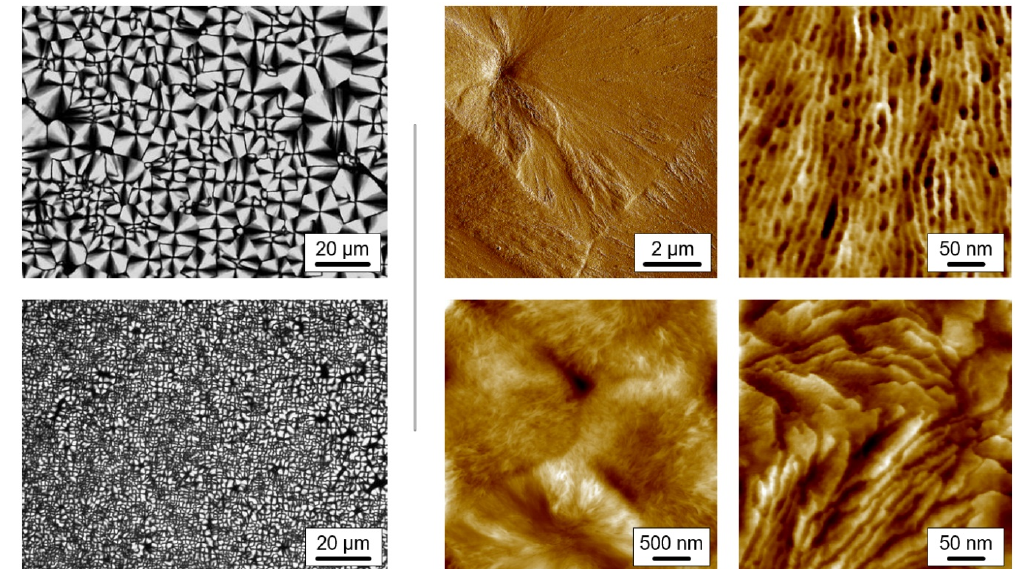
Figure 4. POM-images (left, b/w) and atomic force microscopy *AFM)-images (right, colored) of PBI crystallized at 100 ◦ C. The crystallization temperature was approached either directly by cooling the melt (upper row images, hot-crystallization) or by heating the glass after annealing at 22 ◦ C for more than 12 h, to allow nuclei formation (lower-row images,